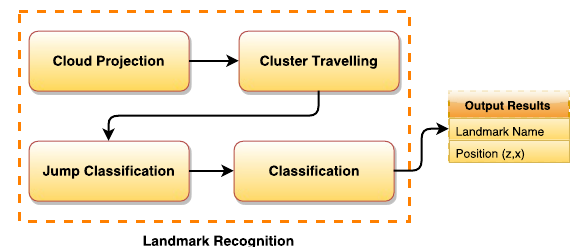
Figure 5. Natural landmark recognition stage.